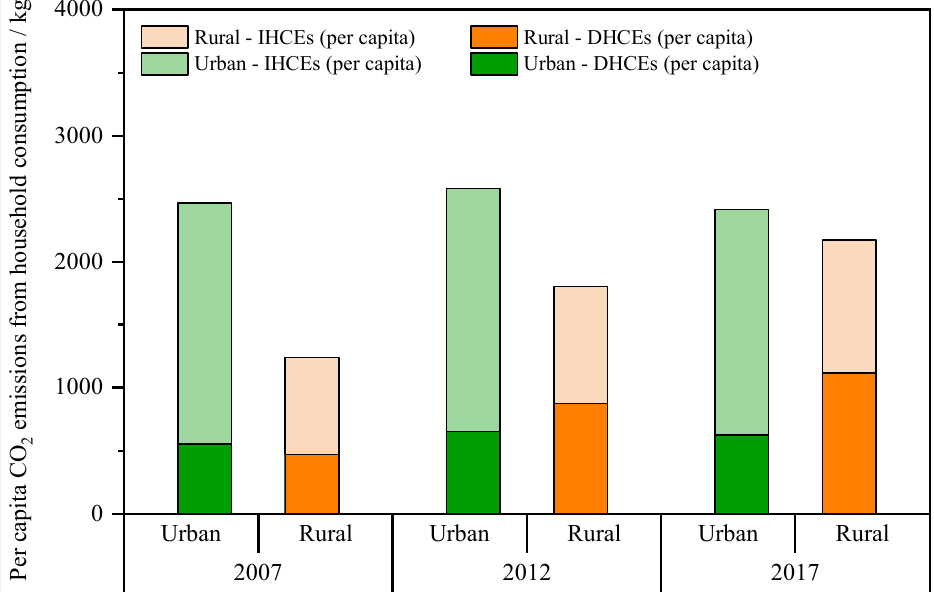
Figure 4. Per capita CO 2 emissions from household consumption in Fujian province.